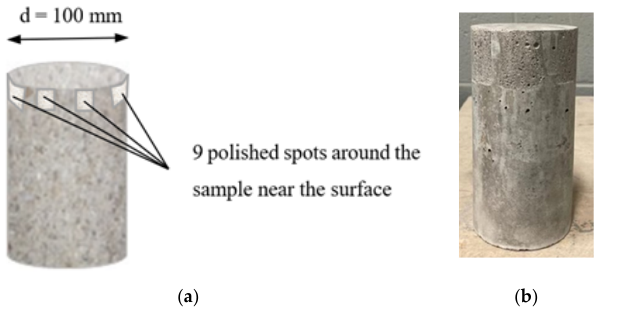
Figure 1. ( a ) Polished spots on a typical sample near the surface to measure the silane penetration depth; ( b ) a cored sample from a bridge deck after polishing.